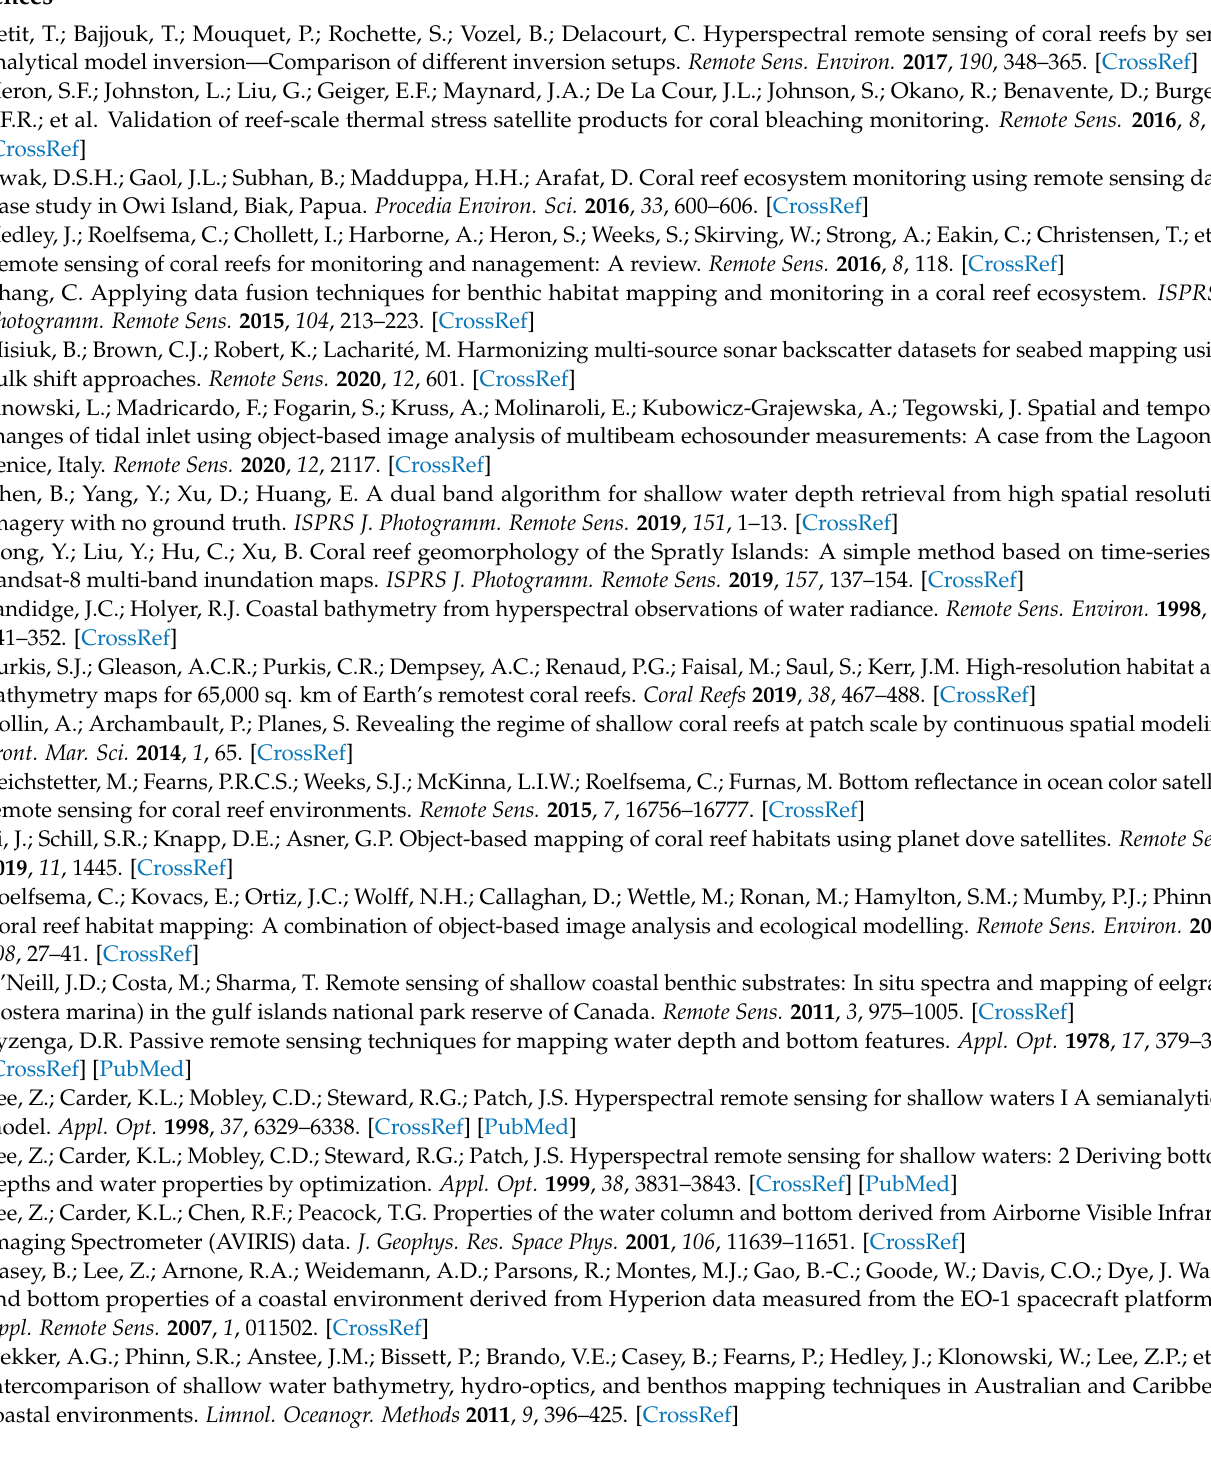
represent different bottom reflectance. Black straight lines represent the water depth contours, and black dotted lines represent the bottom reflectance contours. ( b ) Fitting curve of C i and the corresponding water depth, H . ( c ) Scattered points in ( a ) before and after a clockwise rotation of 20.81 ◦ (–20.81 ◦ ) to C (cid:48) , where the best correlation with bottom reflectance occurs. ( d ) Exponential fitting i curve of C (cid:48) and bottom reflectance, B . ( e ) Fitting curve of the inversion result B2 and Hydrolight i input value B1 . ( f ) Fitting curve of the inversion result H2 and Hydrolight input value H1